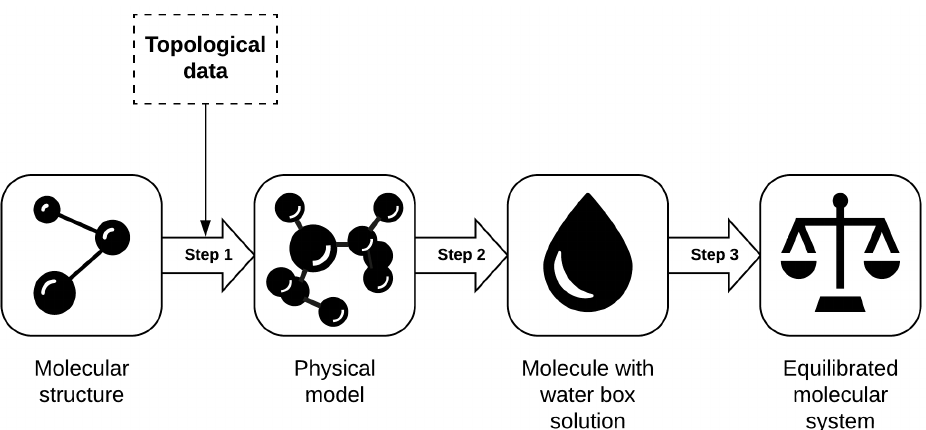
Figure 1. Data pipeline process. Before simulation, the molecular structure needs to be fully